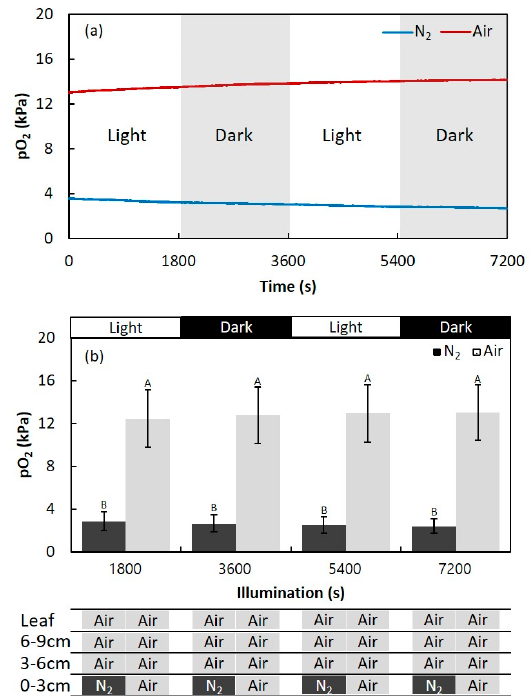
Figure 3. The e ff ect of illumination on the oxygen partial pressure (pO 2 ) in adventitious roots of Syzygium kunstleri . ( a ) Time-trace of pO 2 in adventitious roots during N 2 and air injection with the light conditions controlled. ( b ) The light condition was controlled during injection of air or N 2 into the 0–3-cm section of the stem. Light and dark conditions were alternately changed at intervals of 30 min. The root system was fixed with deoxygenated solid agar (1.5 % w / v ). Values are means ± SD. ( n = 6 roots from 6 individual plants, average of the last one min before changing treatments). The same letter means no significant di ff erence within the same area ( p < 0.05, one-way ANOVA, followed by Tukey’s test for multiple